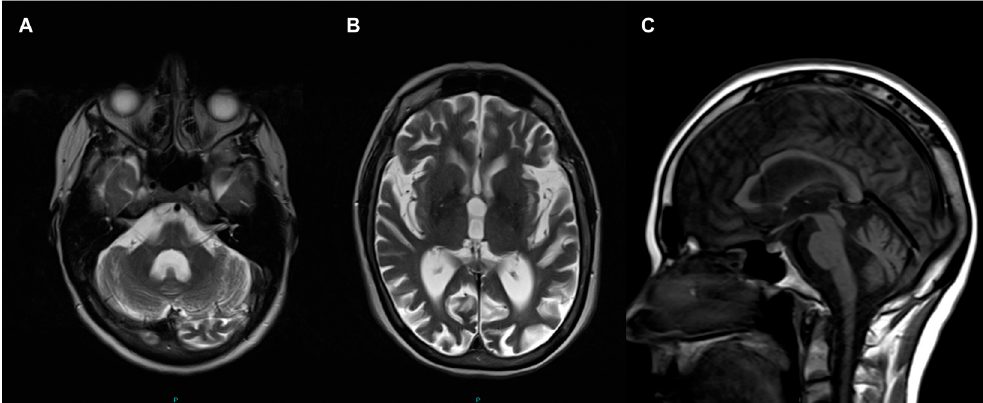
Figure 1. Cranial magnetic resonance imaging (MRI) performed at age 46 years. Enlarged 4th ventricle and hemispheric atrophy of cerebellum ( A ); and dilated ventricles and generalised cerebral atrophy shown in axial T2 ( B ); Sagittal T1 view shows cerebellar atrophy and normal brainstem ( C ). Our patient was tested negative for common spinocerebellar ataxia (SCA) 1, 2, 3, 6, 7